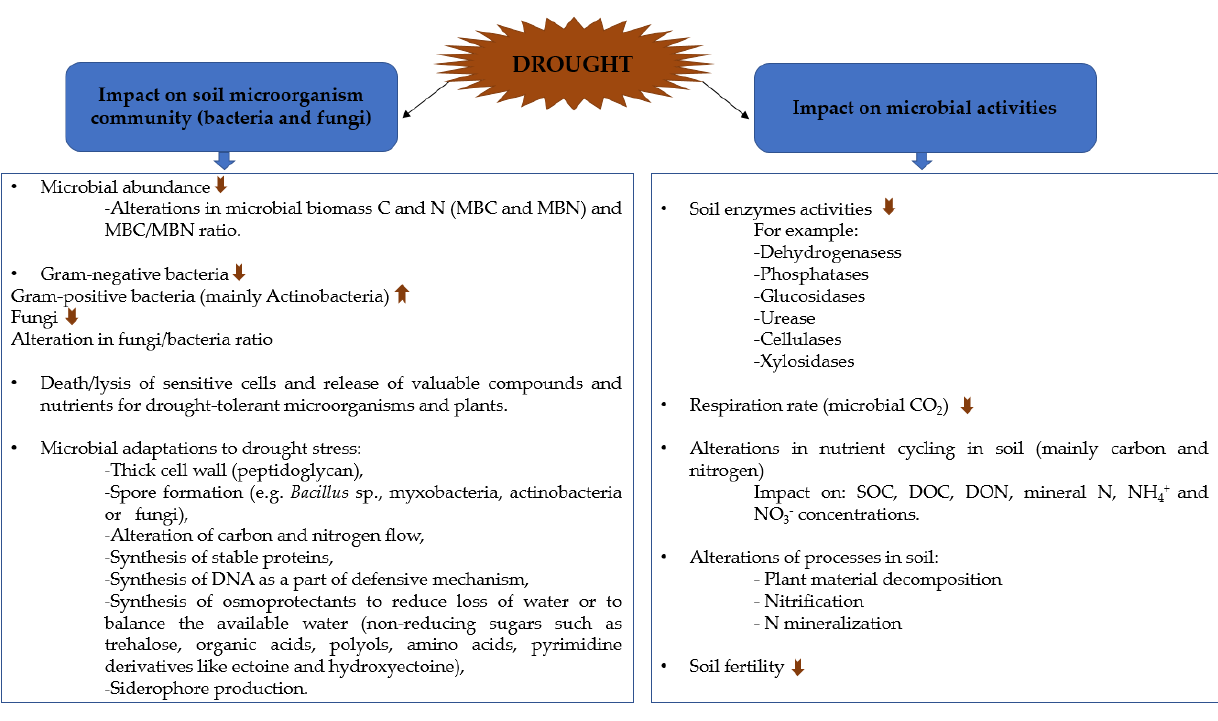
Figure 1. Schematic representation on the impact of drought stress on microbial communities and activities. and